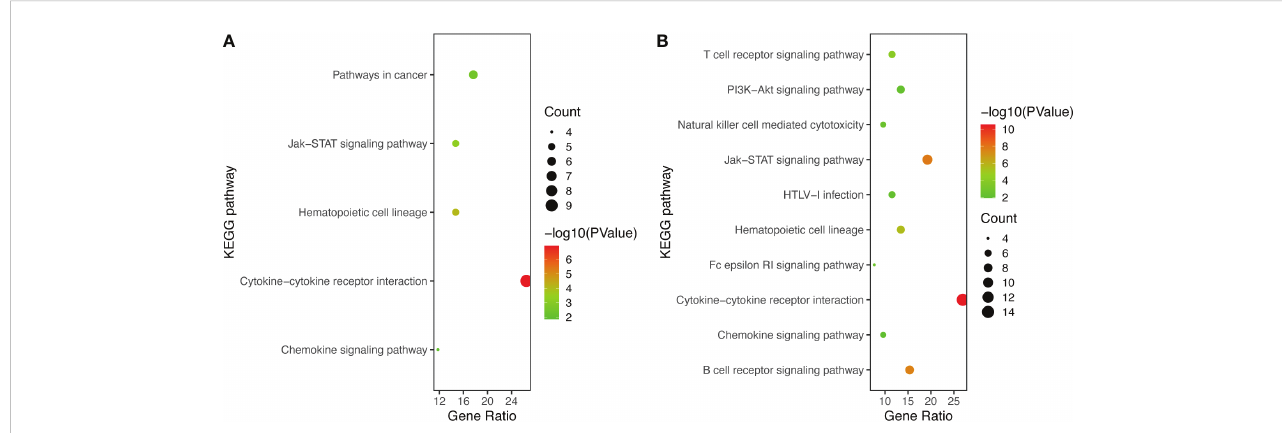
FIGURE 4 The KEGG pathways of DEIRGs. (A) The all 5 enriched KEGG pathways of DEIRGs between Xm TS patients and normal individuals. (B) The top 10 enriched KEGG pathways of DEIRGs between Xp TS patients and normal individuals.